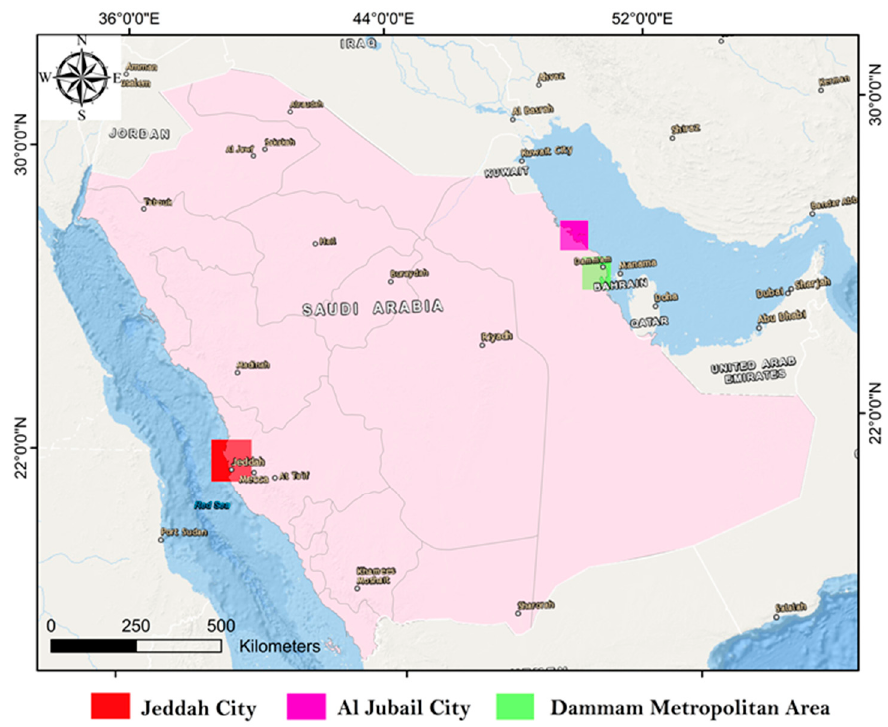
Figure 1. Map of Saudi Arabia illustrating the cities of Jeddah, Jubail, and